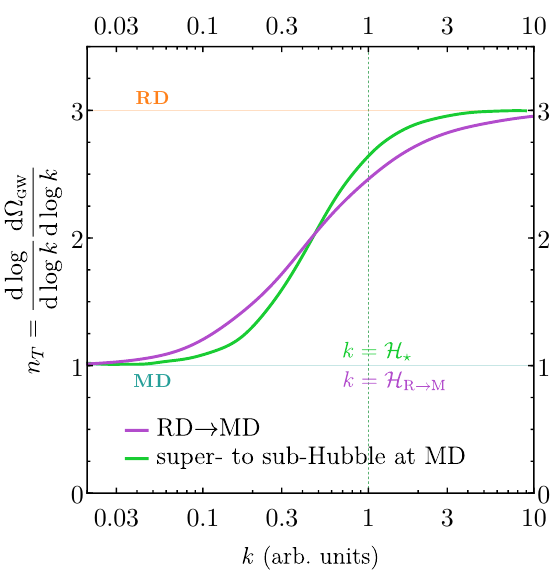
Figure 6 . Comparison between the evolution of the tilt of GW spectra in two different scenarios: transition from sub -horizon modes to MD super-horizon modes (green) and from RD super -horizon modes to MD super-horizon modes (purple). Sub-horizon and RD super-horizon modes both scale as dΩ gw / d log k ∼ k 3 while MD super-horizon modes scale as dΩ gw / d log k ∼ k so that both scenarios have the exponent transition from 3 to 1 . As is shown in the picture, the transition region is different, showing that the two scenarios can in principle be